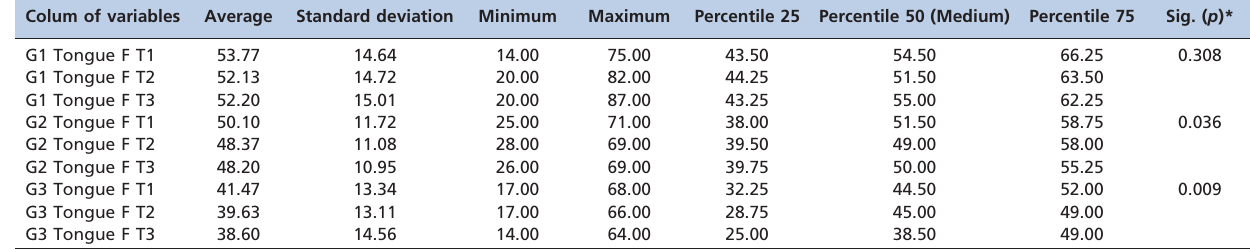
Table 3 - Comparison of force in intragroup swallowing tests. Colum of variables Average Standard deviation Minimum